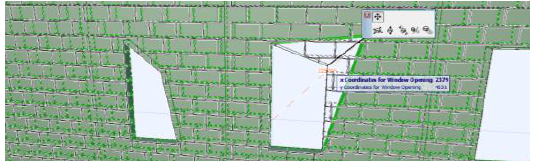
Figure 15. Graphically editing window opening which automatically updates linked elements such as block wall.